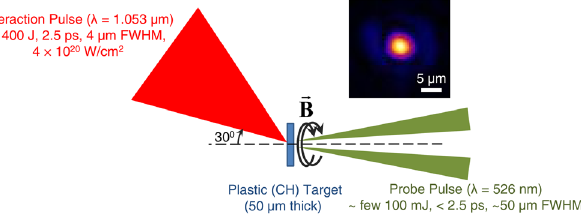
Figure 1. Schematic of the experimental setup, showing the main interaction pulse generating the magnetic fields (B) in the plastic (CH) target, which are probed at the target rear by a time-delayed probe pulse. The inset shows the typical transverse profile of the focal spot of the main interaction pulse on the target.